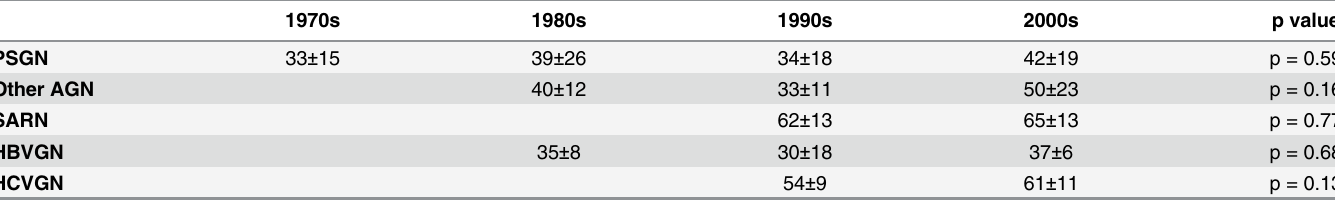
Table 2. The temporal change of the age in each PIGN over the four